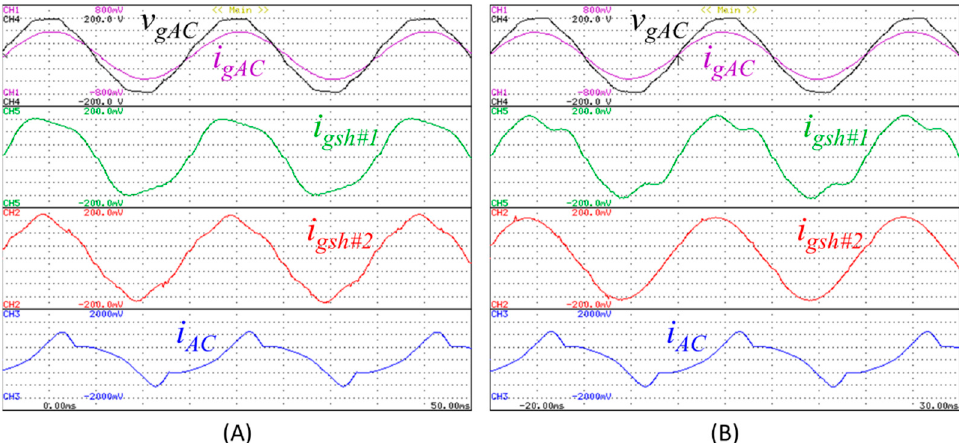
Figure 12. Experimental results showing the voltage ( v gAC ) (100 V/div) and the current ( i gAC ) (20 A/div) on the main AC grid, the current consumed by each front-end AC/DC converter of each smart home ( i gsh# 1 and i gsh# 2 ) (5 A/div), and the current of the AC grid of smart home #1 ( i ACsh# 1 ) (5 A/div): ( A ) Situation when the front-end converter of smart home #1 is used to compensate the current harmonics of order 3, and the front-end AC/DC converter of smart home #2 is used to compensate the current harmonics of order 5; ( B ) Situation when the front-end AC/DC converter of smart home #1 is used to compensate the current harmonics of order 3 and 5, and the front-end AC/DC converter of smart home #2 is used to compensate the reactive power.